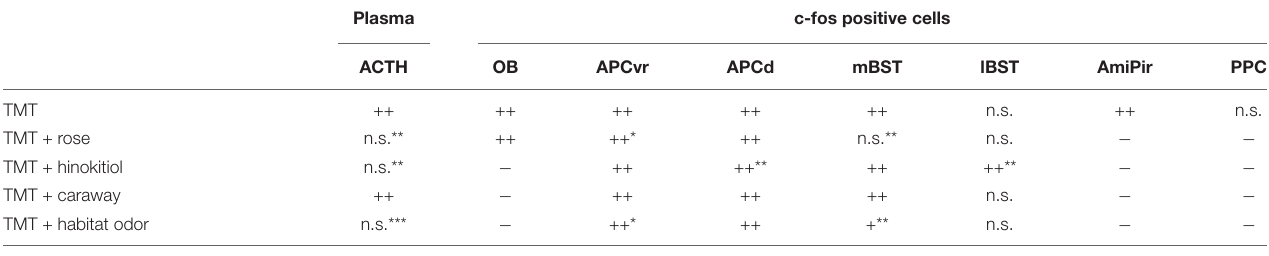
TABLE 1 | Changes in the number of c-fos-positive cells in each brain region following each odor presentation (upper part) and following each electrical stimulation (lower